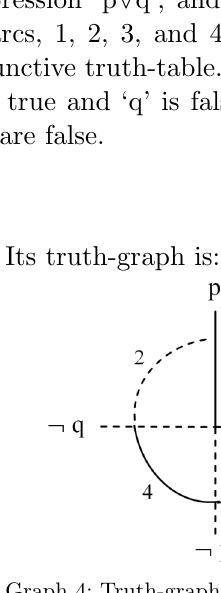
Table 4: Truth-table of implicative Graph 4: Truth-graph of implicative expression